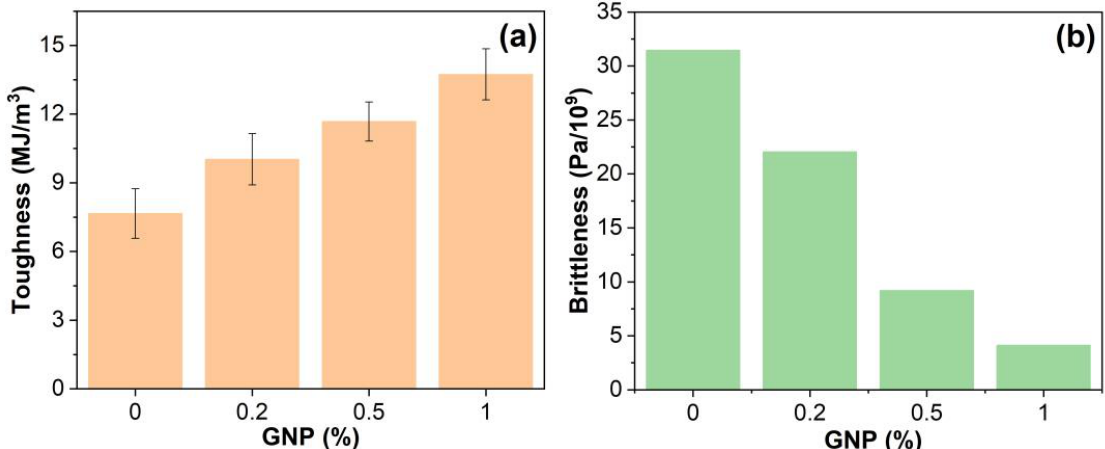
Figure 11. Toughness ( a ) and brittleness ( b ) of GNP-reinforced EABCs.